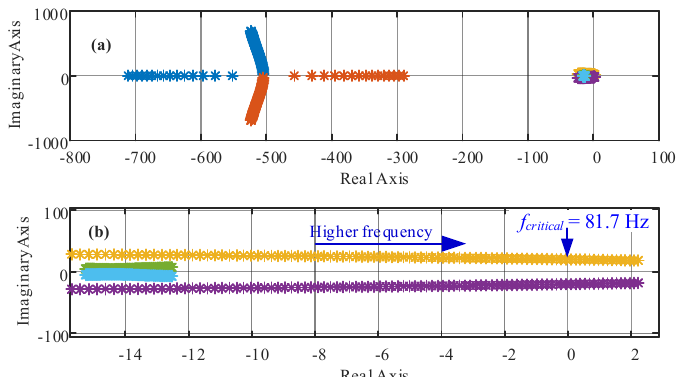
Figure 4. A L eigenvalues as a function of the ac main frequency (from 30 to 100 Hz); ( a ) all six values; ( b ) zoom to the unstable eigenvalues. Table 2. Critical frequency for static decoupler.